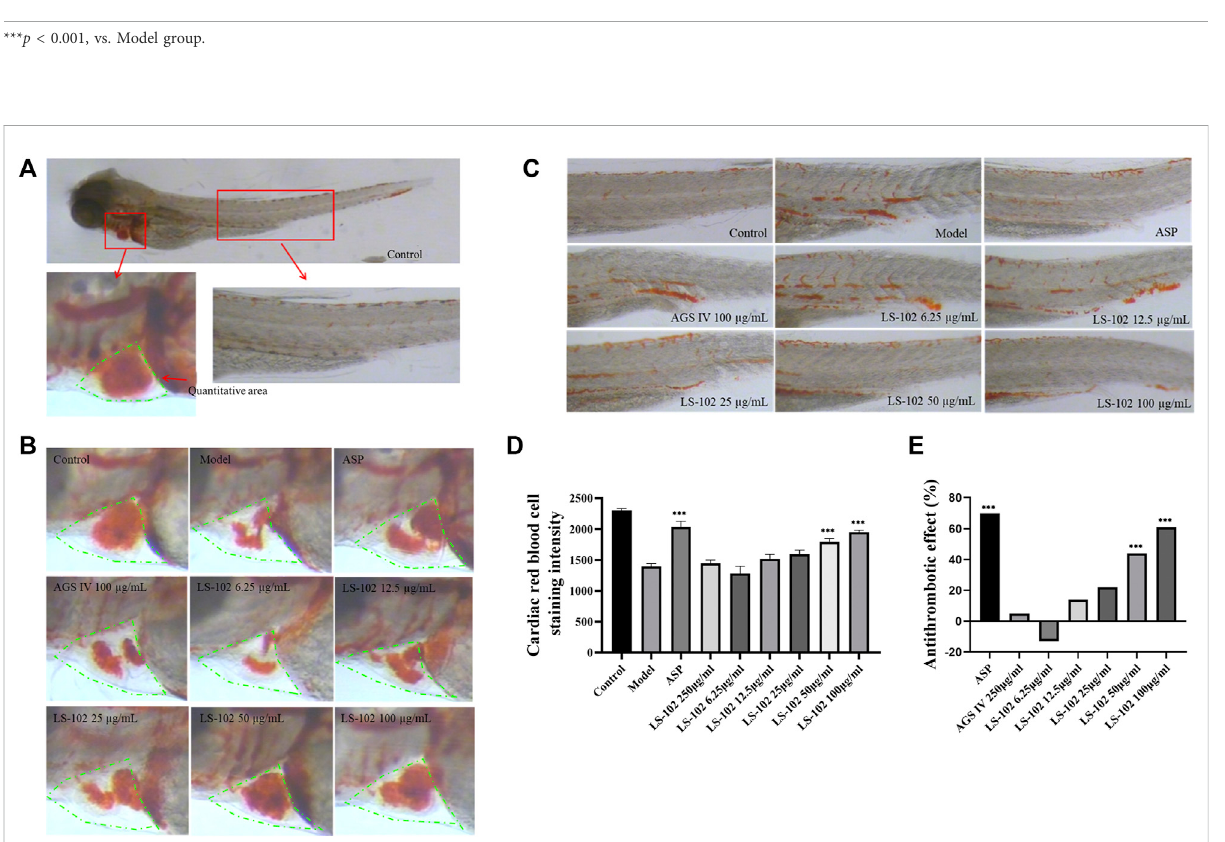
FIGURE 6 (A) 3 dpf Albino strain zebra fi sh stained with o-Dianisidine (green area is the quantitative red blood cell area). (B) Typical staining of zebra fi sh heart red blood cells after AGS IV and LS-102 treatment. (C) Typical graph for qualitative evaluation of zebra fi sh thrombosis after AGS IV and LS-102 treatment. (D) Erythrocytestainingintensity(pixels)inzebra fi shheartstreatedwithLS-102andAGSIV. (E) Thrombosispreventioninzebra fi shtreated with LS-102 and AGS IV. *** p < 0.001, vs. Model